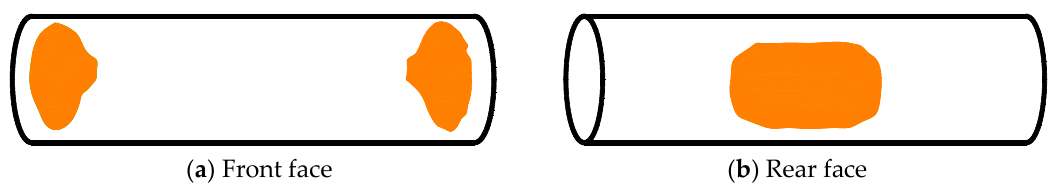
Figure 2. Plastic strain diagram of cylindrical shell in UNDEX test (Adapted from reference